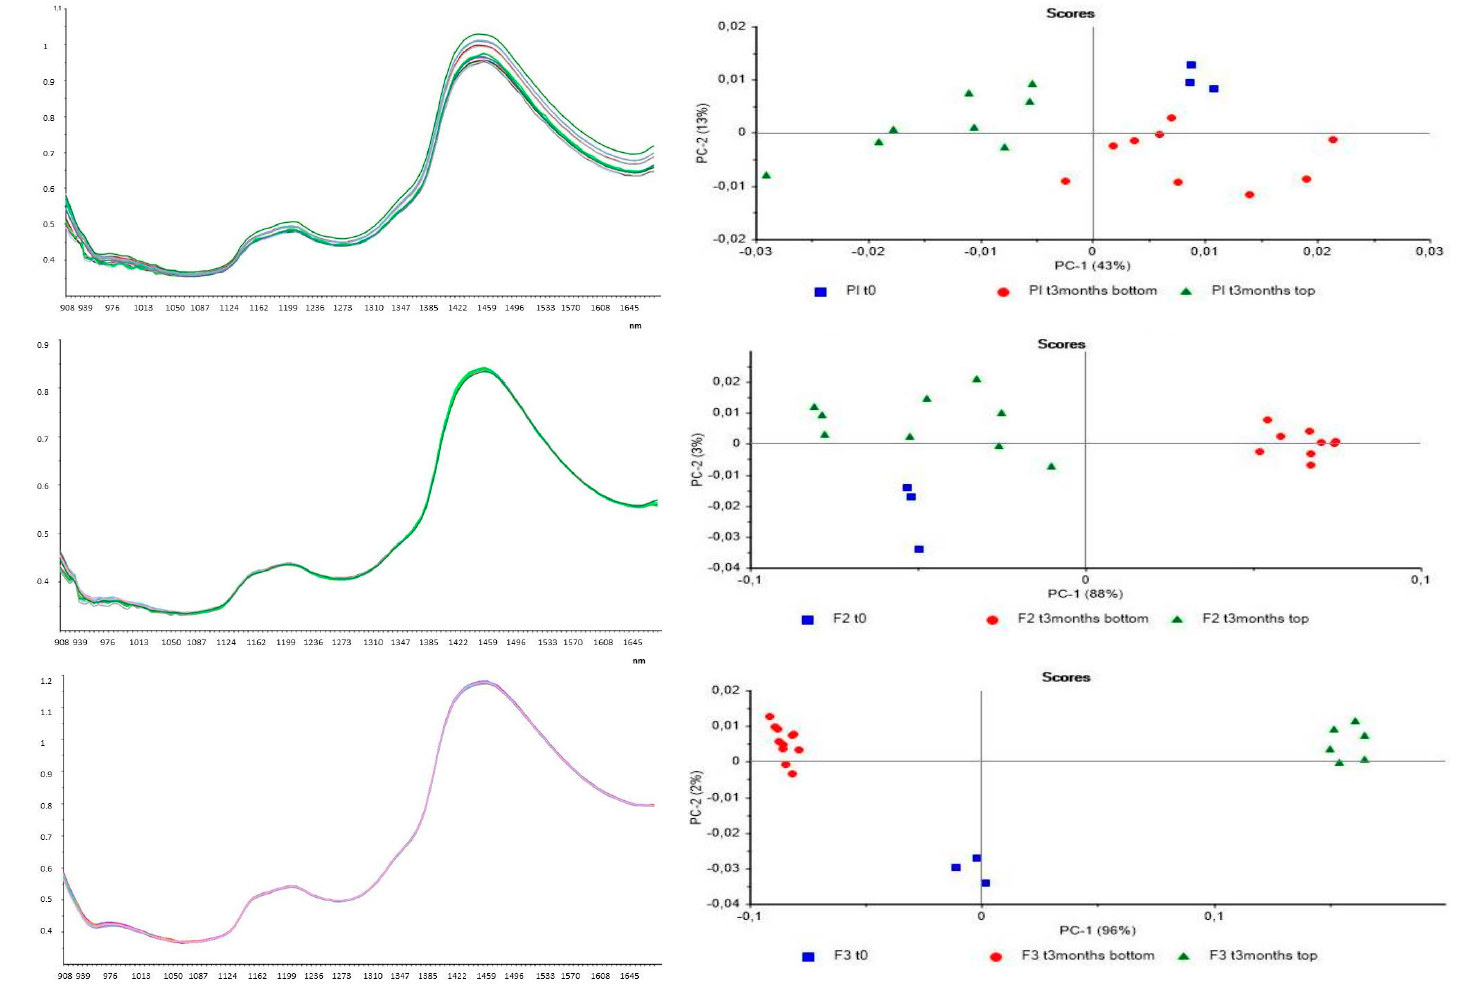
Figure 8. Left spectra and right PCA of from the top: placebo t0 (first three lines from above) and after three months, top (three lines in the center) and bottom (three lines below); F2 t0 (green line) and after three months, top ( blue line) and bottom (purple line); F3 t0 (purple line)and after three months, top (red line) and bottom (green line).